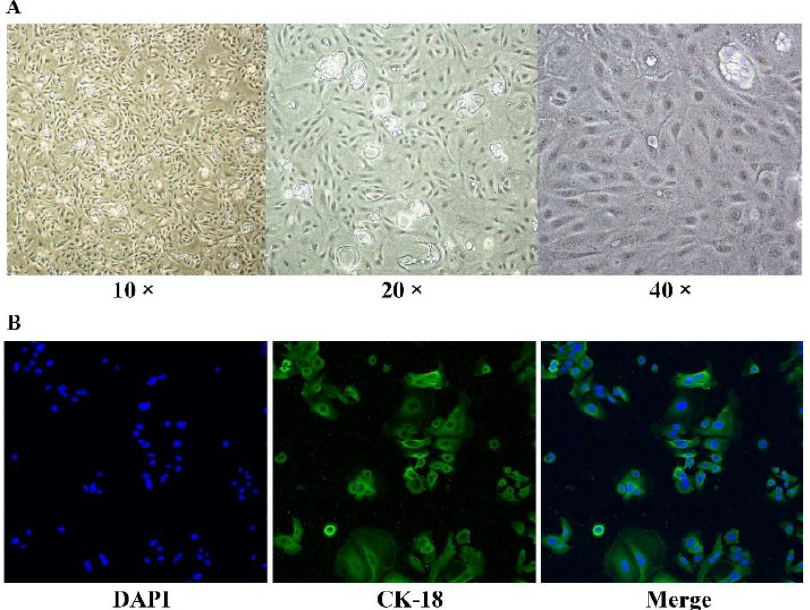
Figure 2. BMECs isolation. ( A ) Separation and purification of the BMECs. ( B ) CK-18 immunofluorescence and DAPI dying results of the BMECs (200×).